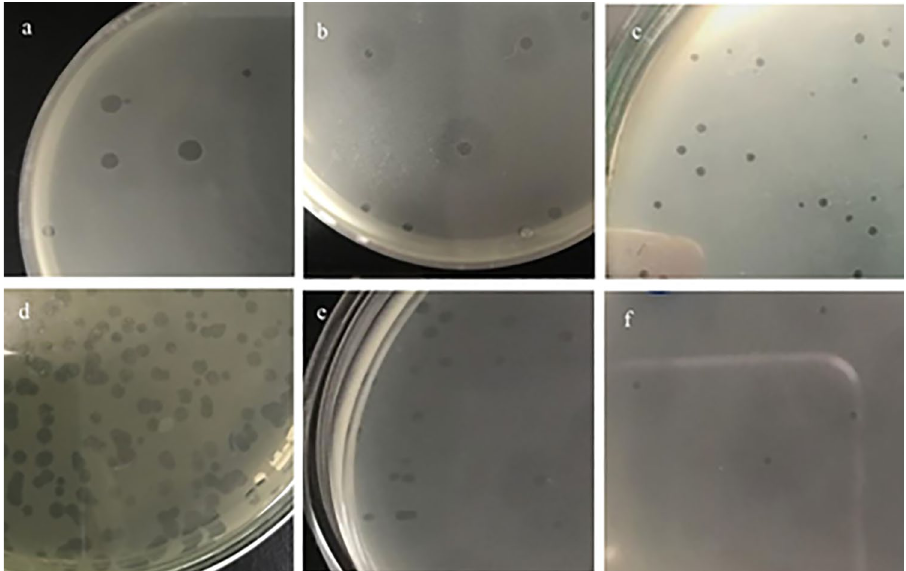
Figure 1. Plaques pictures of the 6 bacteriophages (EPA: F), as formed on Enterococcus double layer agar plates. ( a ) EPA: large plaques (diameter: up to 4 mm) with hallow zones. ( b ) EPB: medium plaques (diameter: 2–3 mm) with hallow zone. ( c ) EPC: medium plaques (diameter: 1–2 mm) without hallow zones. ( d ) EPD: large plaques (diameter: up to 4 mm) without hallow zone. ( e ) EPE: medium plaques (diameter: 1 mm) with hallow zone. ( f ) EPF: pinpoint plaques (diameter: < 1 mm) with hallow zone.